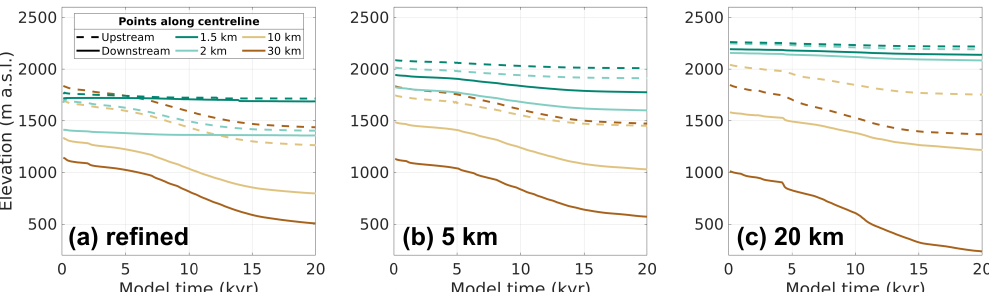
Figure 10. Evolution of the ice surface at equidistant points up- and downstream of the nunatak summit along the centreline (cf. Fig. 5c, d) in control runs with one nunatak with (a) the refined mesh (first presented in Fig. 5c), (b) the 5km regular mesh, and (c) the 20km regular mesh. Complementing Fig. 9, this figure shows that different estimates of surface elevation in the coarser-mesh experiments also affect how elevation evolves as the ice thins and therefore the resulting thinning